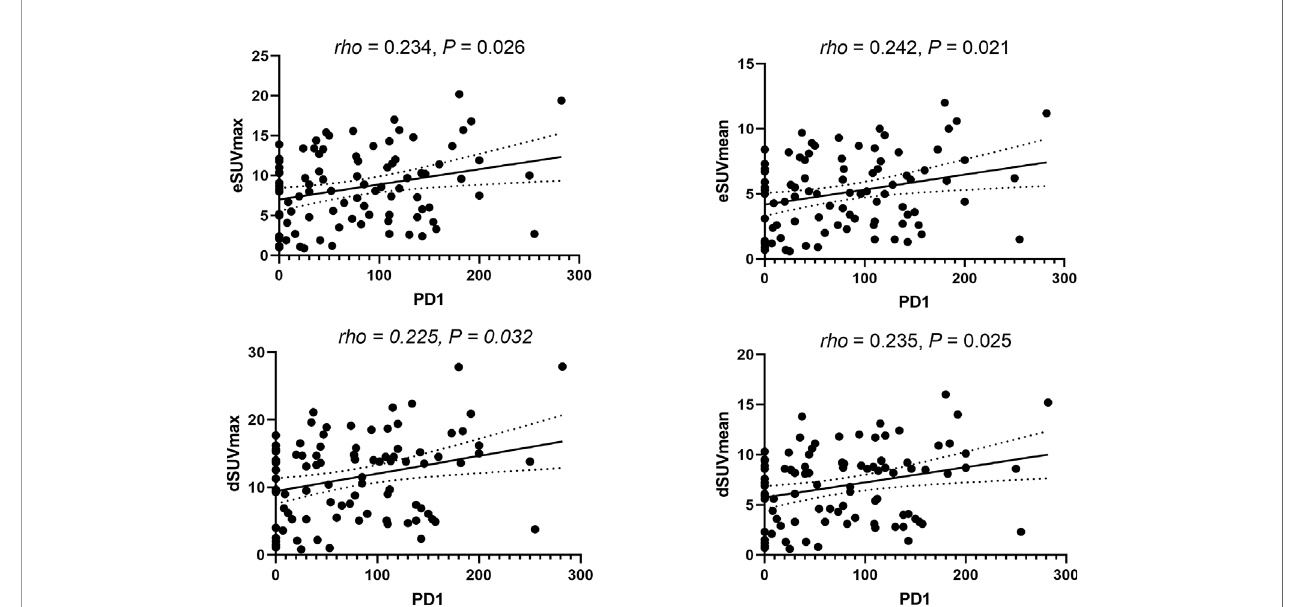
FIGURE 3 | Correlations between metabolic parameters and PD-1